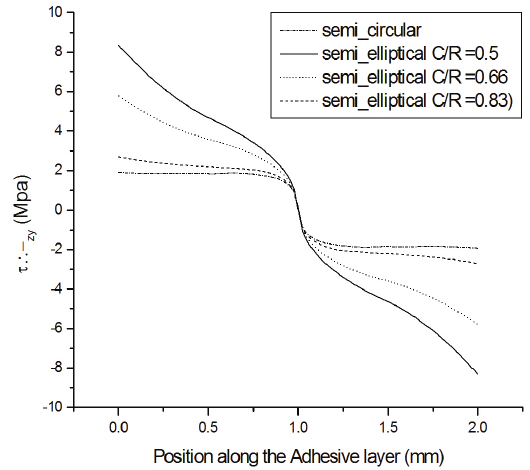
Figure 5. Distribution of the adhesive shear stresses τ